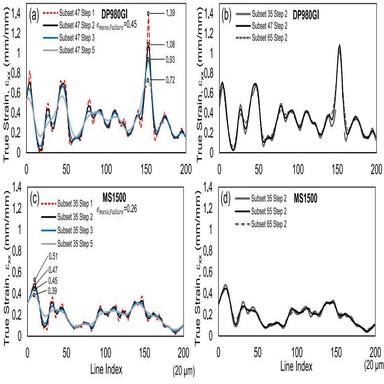
The variation in strain distribution with respect to step size and subset size for (a,b) DP980GI and (c,d) MS1500.